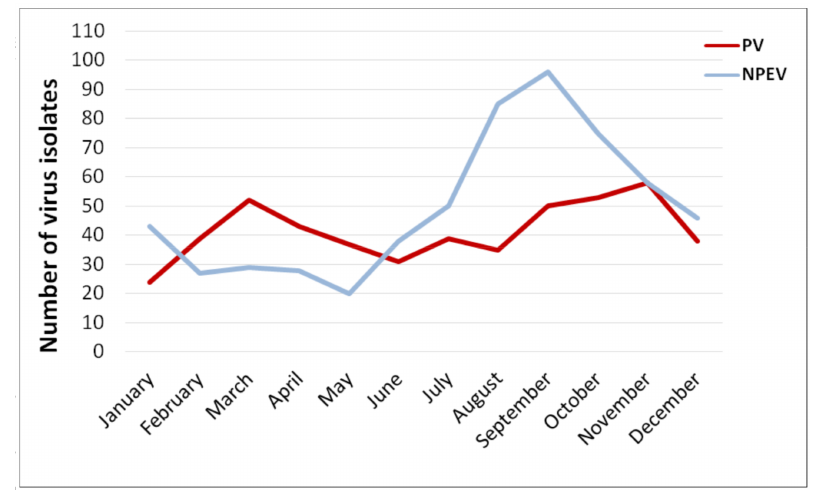
Figure 4. Average monthly isolation of polio and non-polio enteroviruses in sewage samples, Moscow, 2004–2017. NTVs are not included in the NPEV